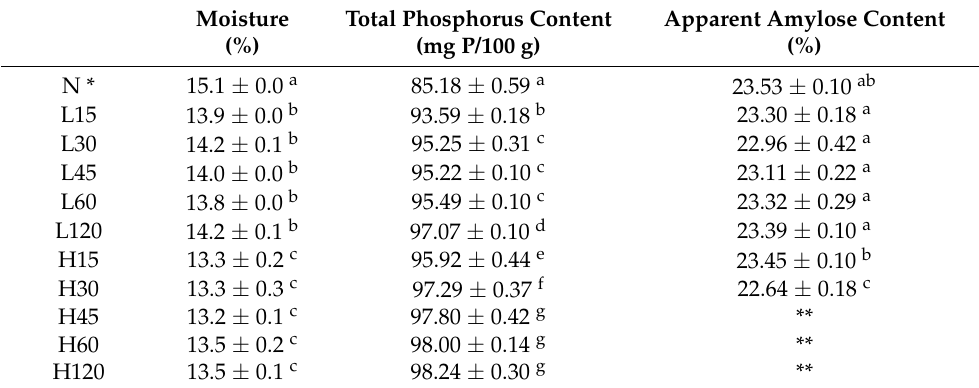
Table 1. Chemical composition of